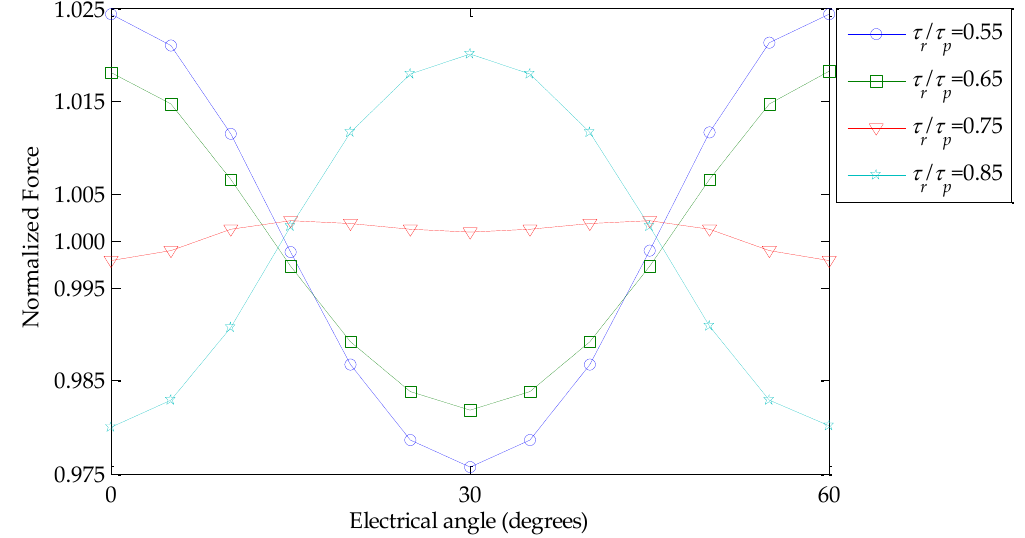
Figure 6. Normalized force computed over a θ e range of 60 degrees for four τ r / τ p variations with N CPMs = 0.4, N PMi = 0.6, n form = 1.2, and J rms = 3 A/mm 2 .